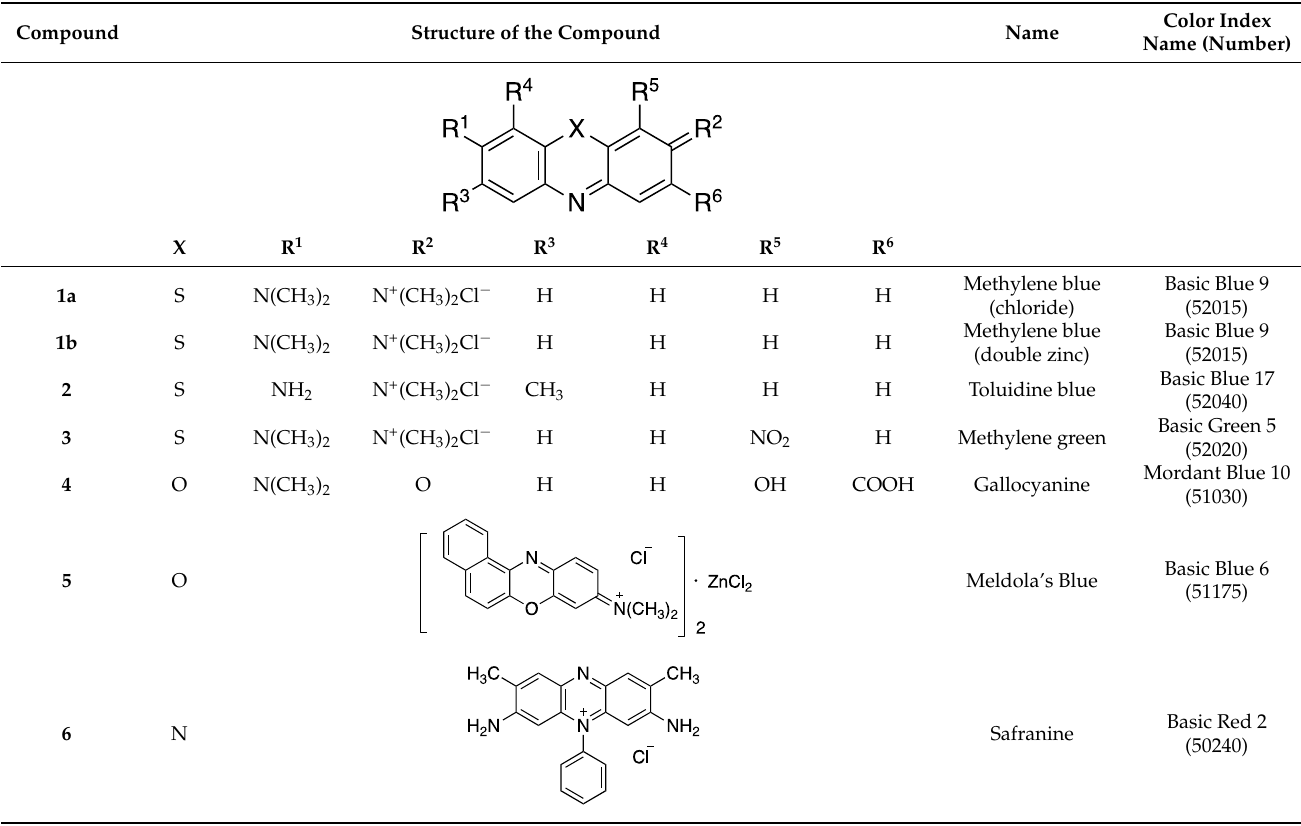
Table 1. Arylamine (phenothiazine, phenooxazine and phenodiazine) dyes.